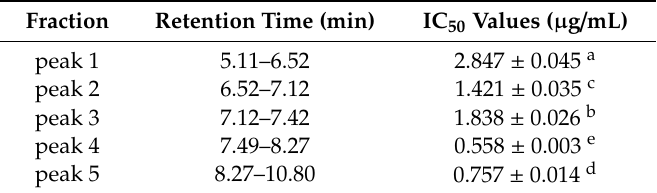
Figure 2. The chromatograms measured at 220 nm of SPD-VII by NGC Quest ™ 10 Plus Chromatography System. The red numbers 1-5 represent peaks 1-5 respectively. Table 2. The IC 50 values inhibiting ACE activity of peaks 1-5 eluted from SPDS-VII.